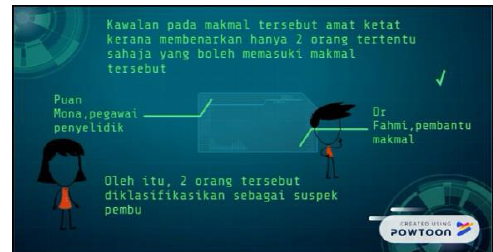
Figure 1: Paper Chromatography Method